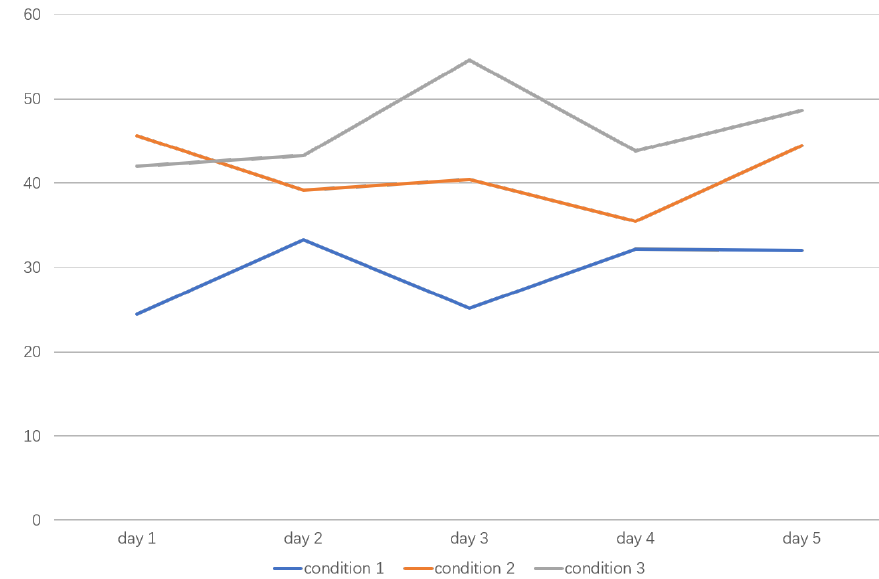
Figure 8. Changes in the average number of pages per session per person from day 1 to day